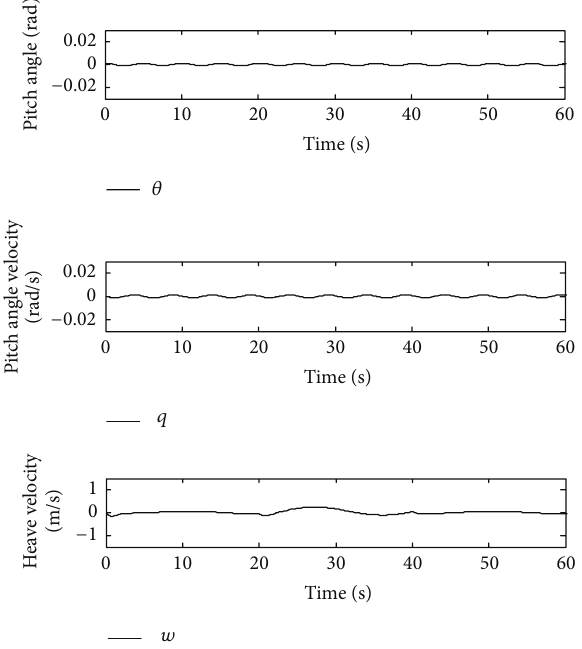
Figure 4: State variables changing trend of REMUS AUV.